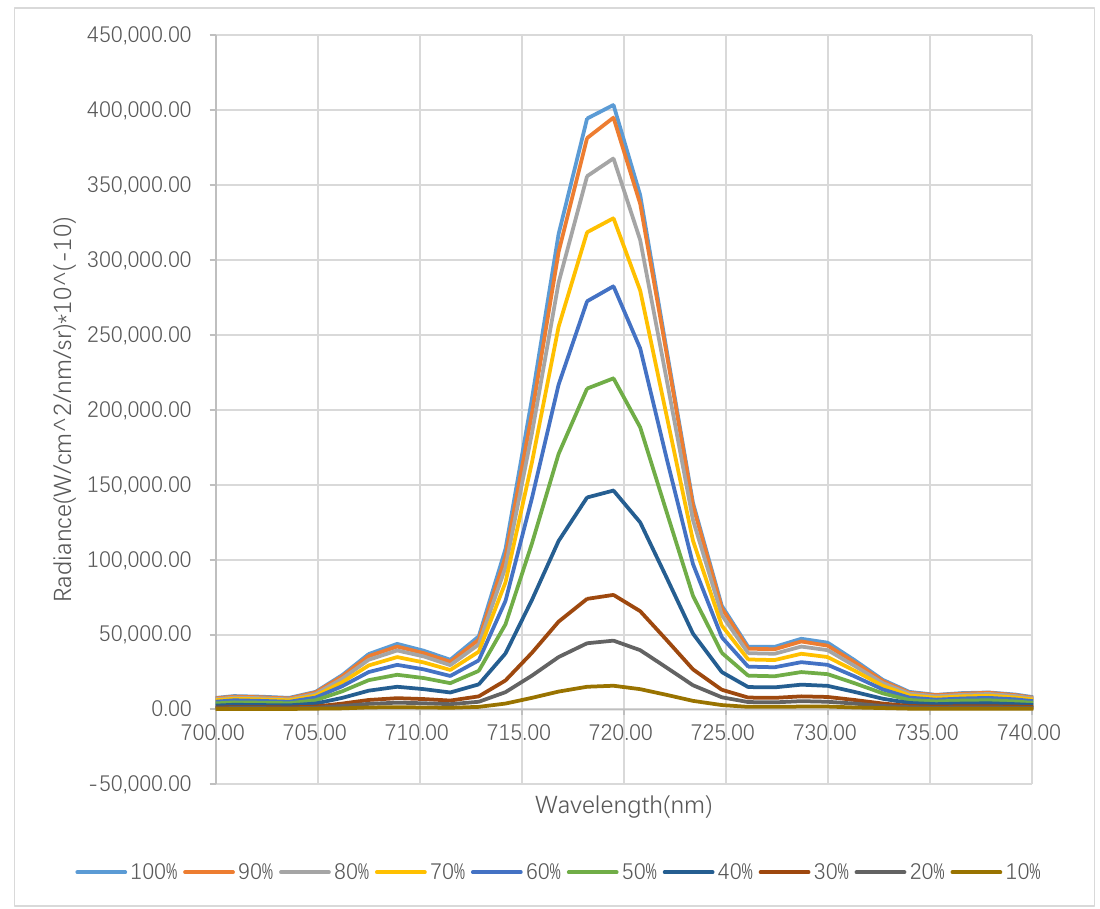
Figure 4. Output of the SVC ® spectrometer by modifying the transmission power of the supercontinuum laser (SCL) source from 10–100% with a 10% step length at 720 nm on a white reflectance standard with 99% reflectivity .